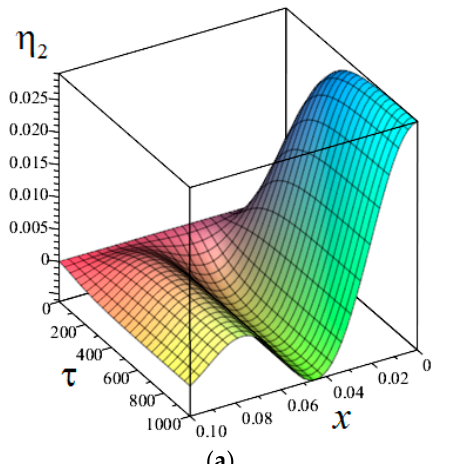
Figure 5. ( a ) Displacement u ; and ( b ) concentration increment